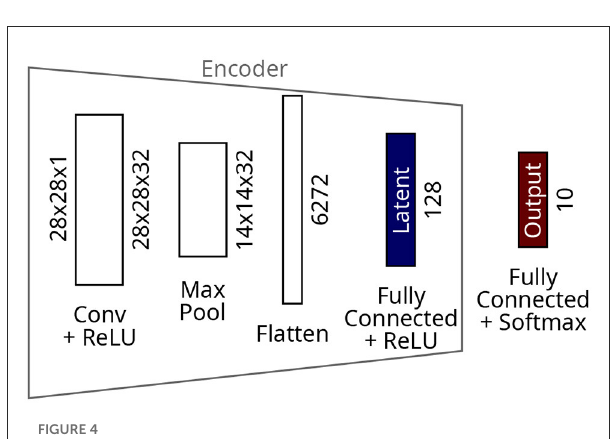
FIGURE4 Architecture of the CNN for the MNIST dataset.